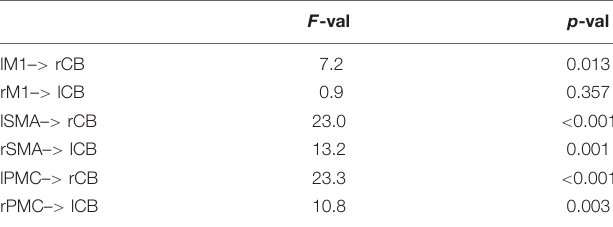
TABLE 5 | Modulatory parameters in the winning cortico-striato-thalamo-cerebellar model (main effect of COND: RND >